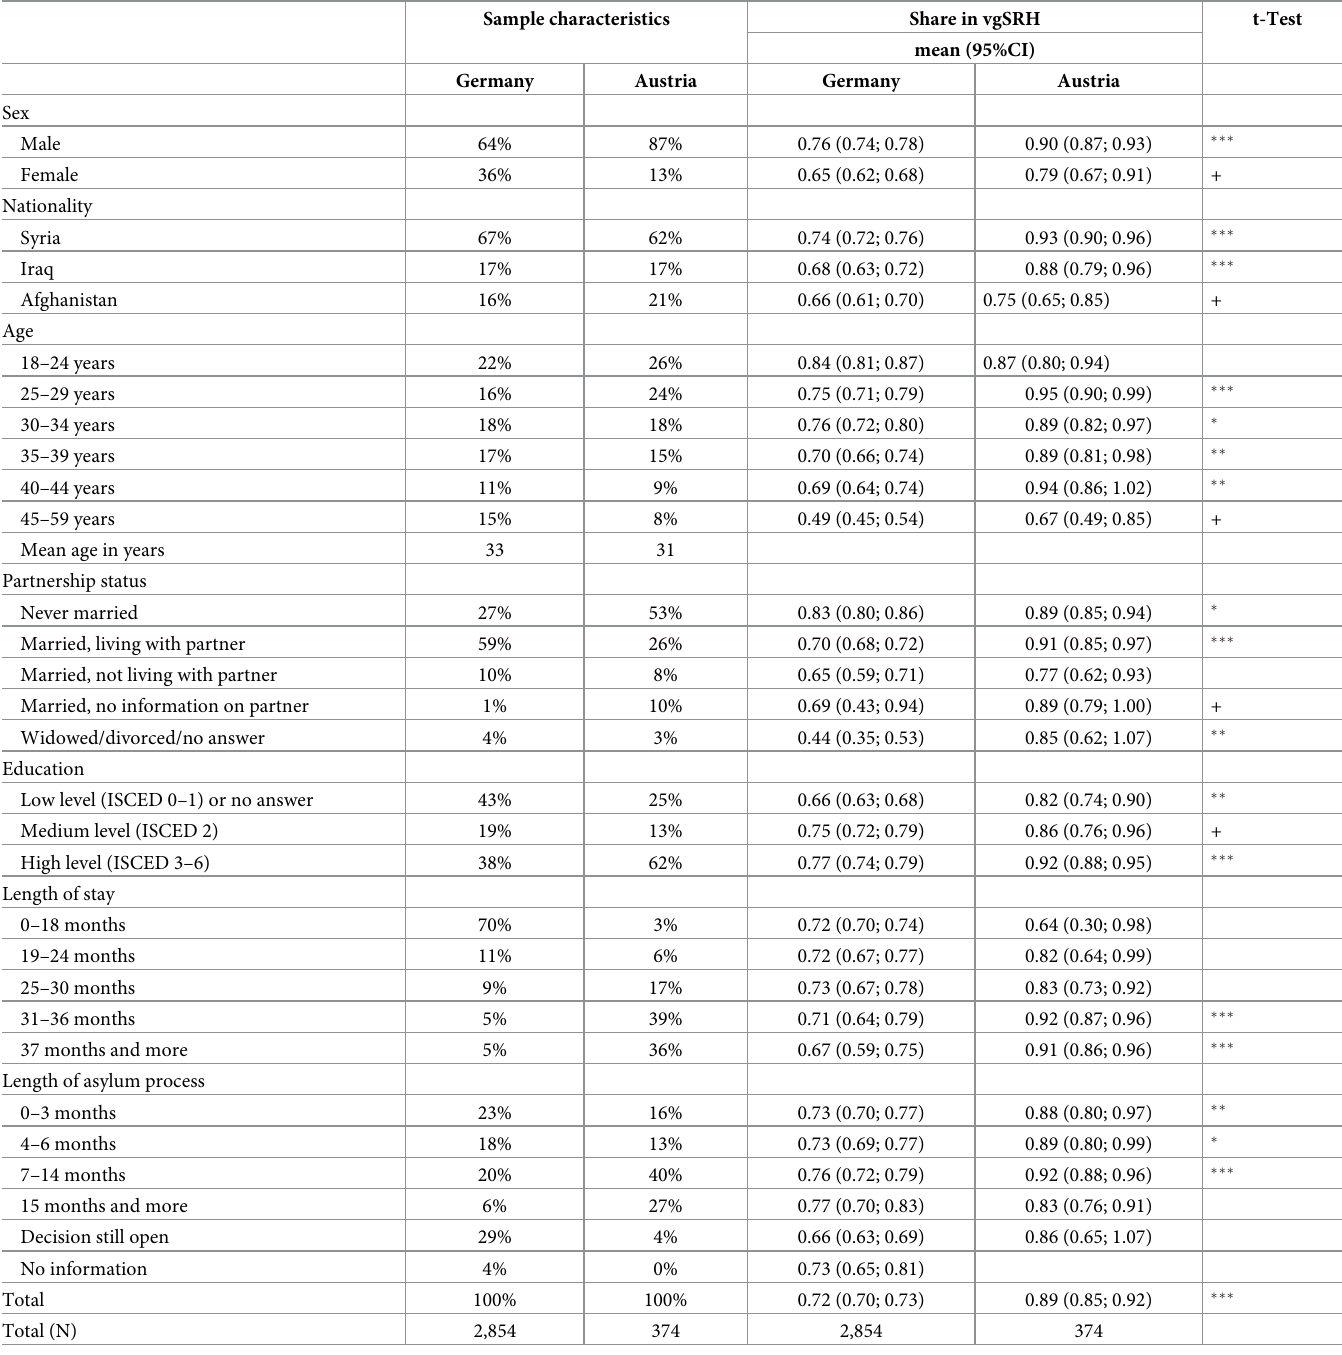
Table 1. Sample characteristics of AS&R and share in vgSRH, by country.